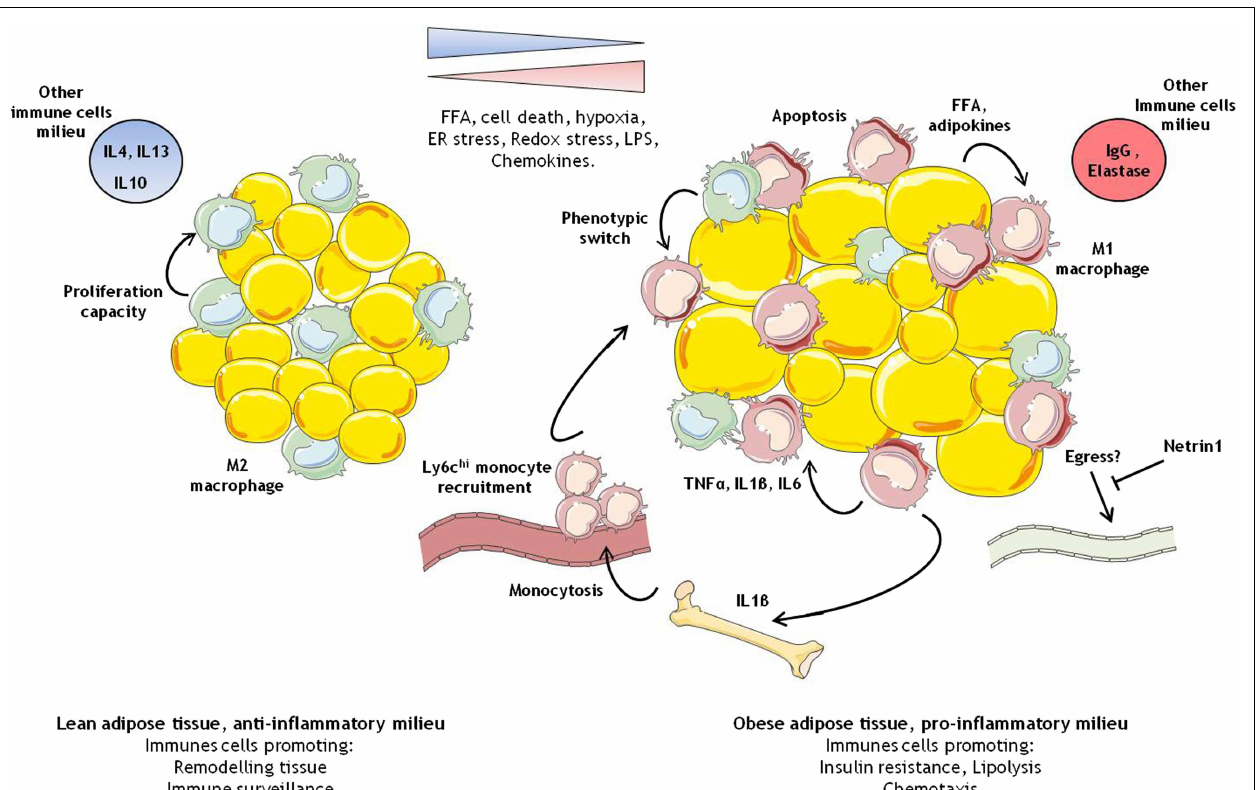
development of a pro-inflammatory environment. In this context, M1 like macrophages start to accumulate due to some M2 macrophages switching phenotype, bone marrow stimulation of myelopoiesis contributing to the recruitment of pro-inflammatory monocytes, and possibly reduced egress of